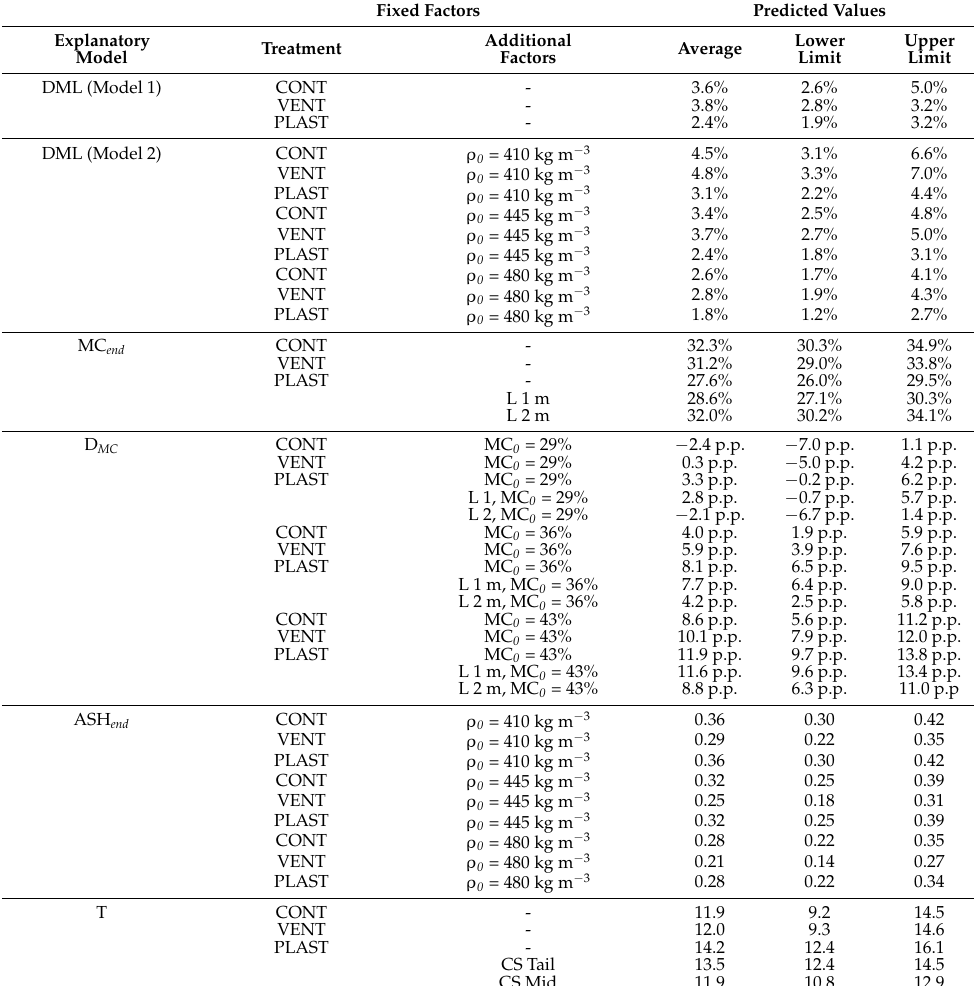
Table 4. The predicted average values with 95% confidence limits for the response variables within the range of the values of additional fixed factors used in